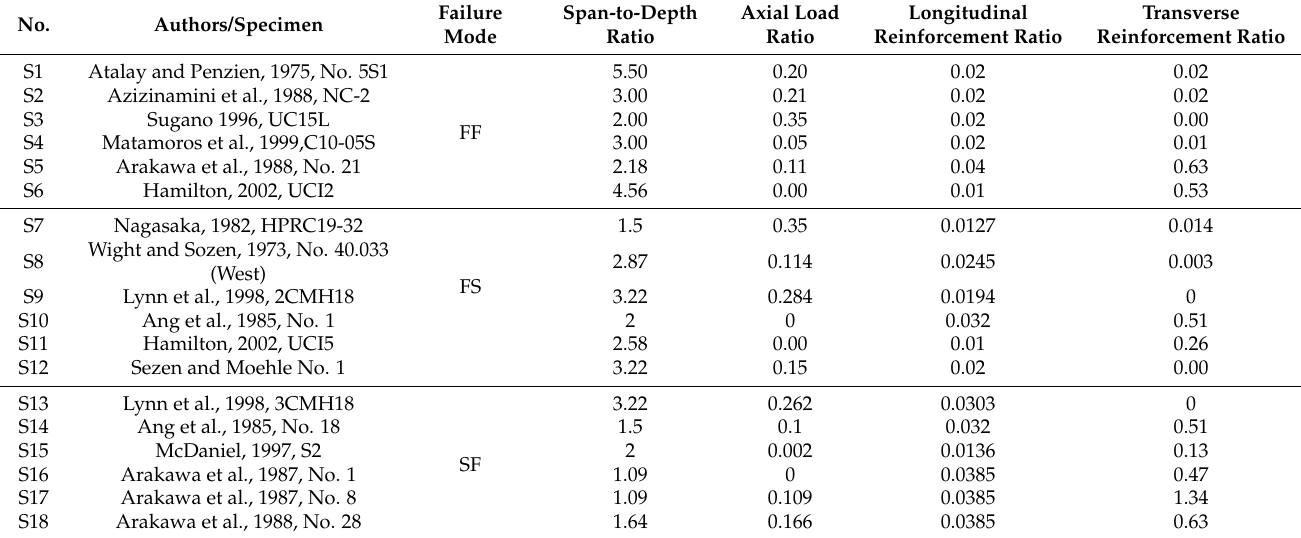
Table 2. Test samples of RC Columns with different